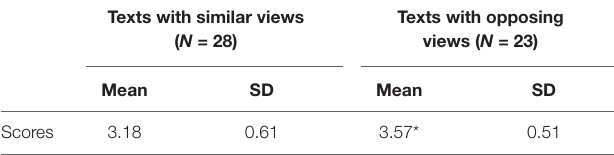
TABLE 3 | Quality of essays by two groups.